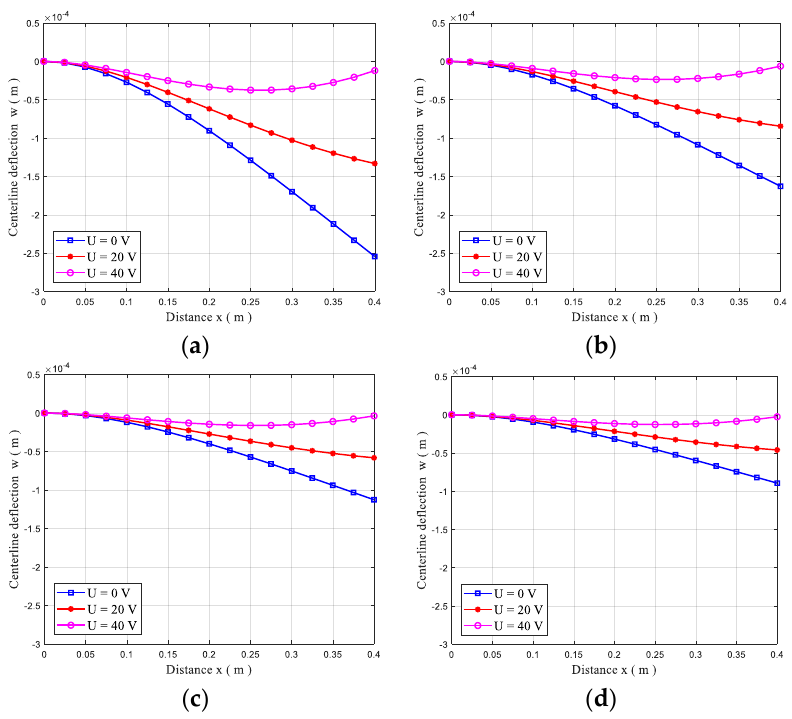
Figure 8. Deflection of a PFGP under the action of electromechanical loads: ( a ) n = 0; ( b ) n = 0.5; ( c ) n = 5; ( d ) n = ∞.